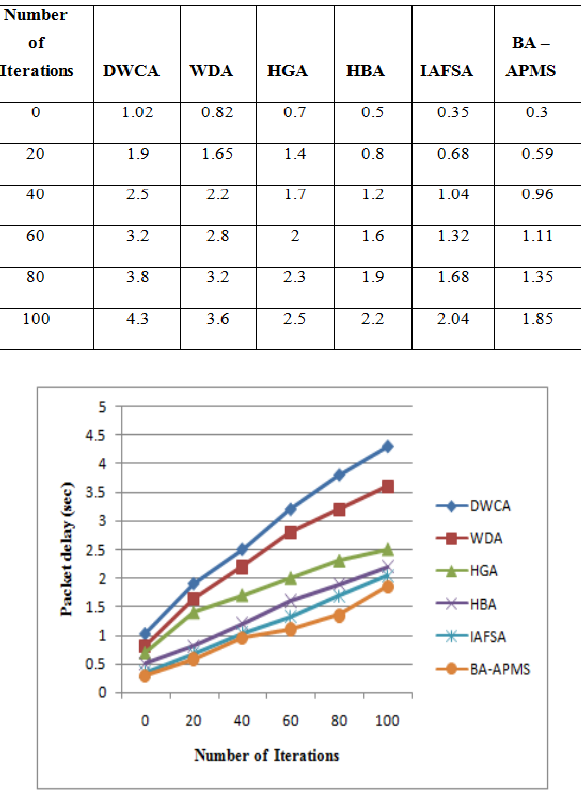
Figure 3. Packet Delay